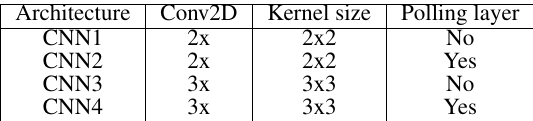
Table 2. Different CNN architectures used in this study. Architecture